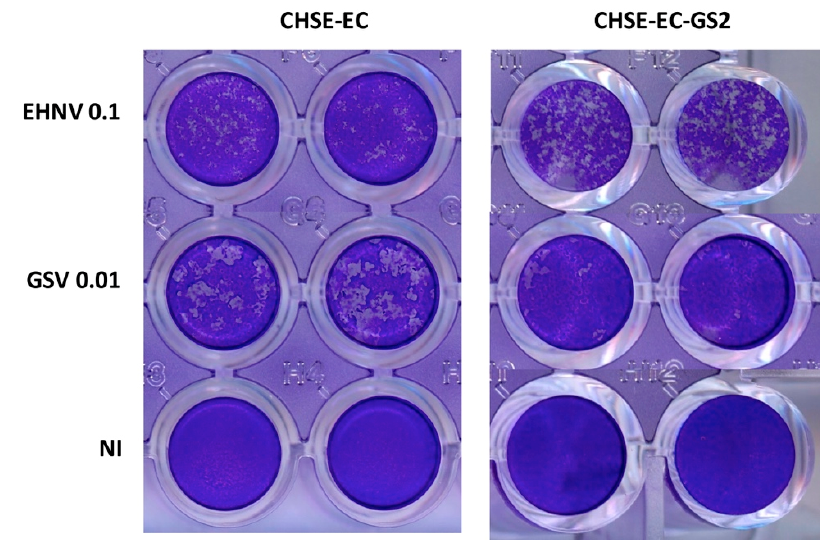
Figure 2. Cytopathic effect of infection with an aquareovirus (golden shiner virus, GSV, MOI = 0.01) or a Ranavirus (epizootic haematopoietic necrosis virus, EHNV, MOI = 0.1) on a salmonid stat2+/+ (EC) or stat2-/- (GS2) cell line. NI: non infected.